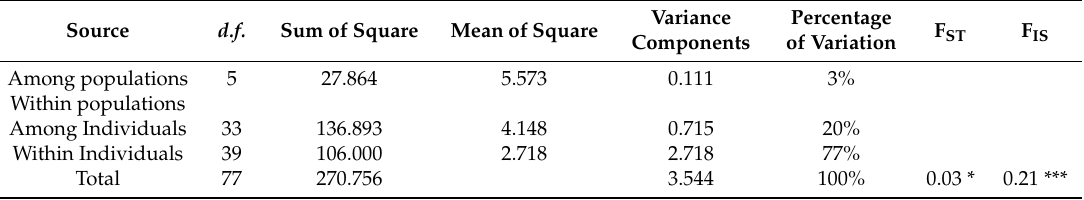
Table 5. Analysis of molecular variance (AMOVA) for six populations of D. odorifera .